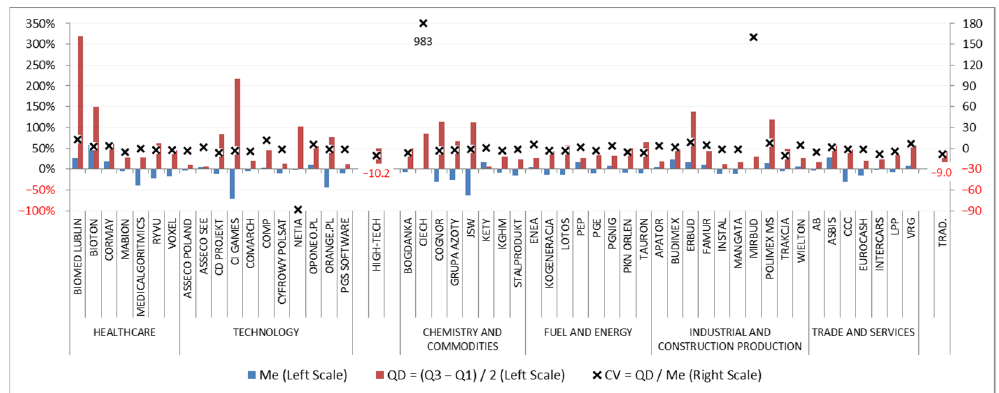
Figure 16. Assessment of the variation of the rate of return on assets in the surveyed enterprises. Source: own work.